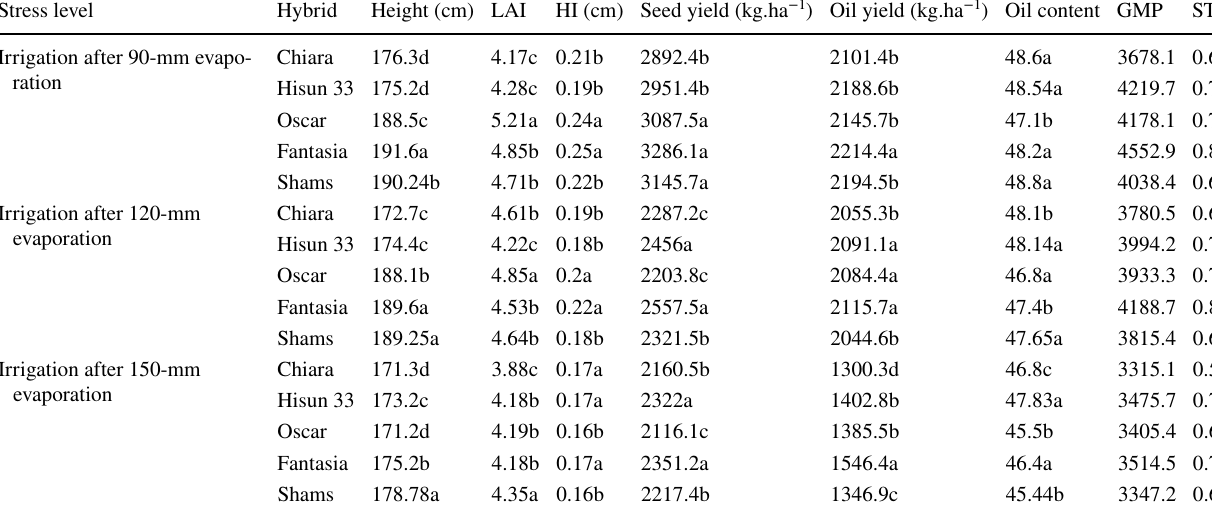
Table 4 Comparison of mean grain traits under the influence of water deficit stress interaction and cultivar as well as drought indices of sun- flower cultivars in different stages of irrigation and mean water-deficit stress conditions Stress